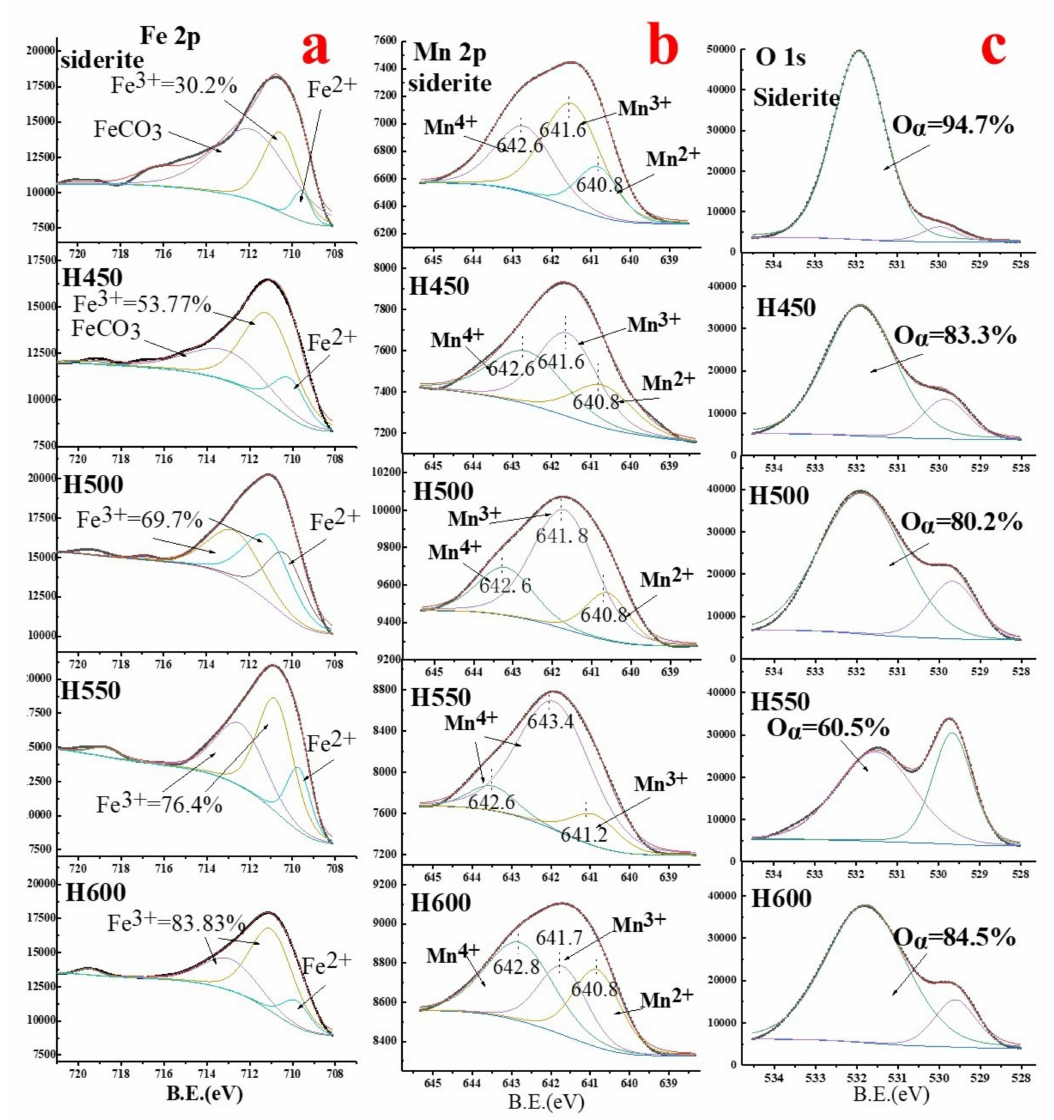
Figure 3. XPS spectra of Fe 2p ( a ), O 1s ( b ), and Mn 2p ( c ) of the natural siderite and thermally treated